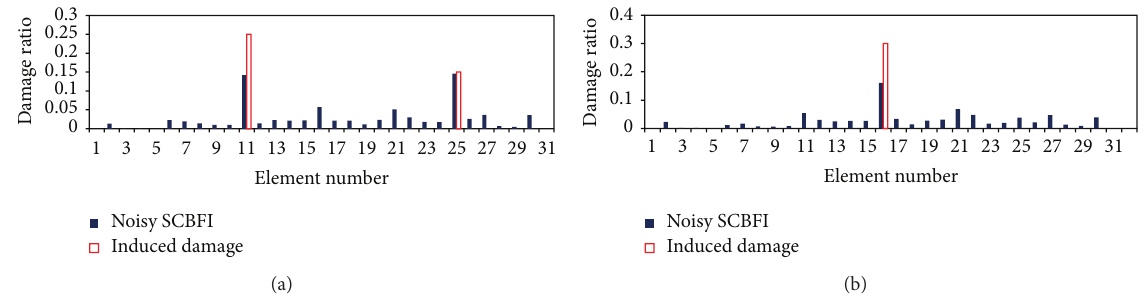
Figure 13: The SCBFI for 31-bar truss considering 1% noise for (a) case 1 and (b) case